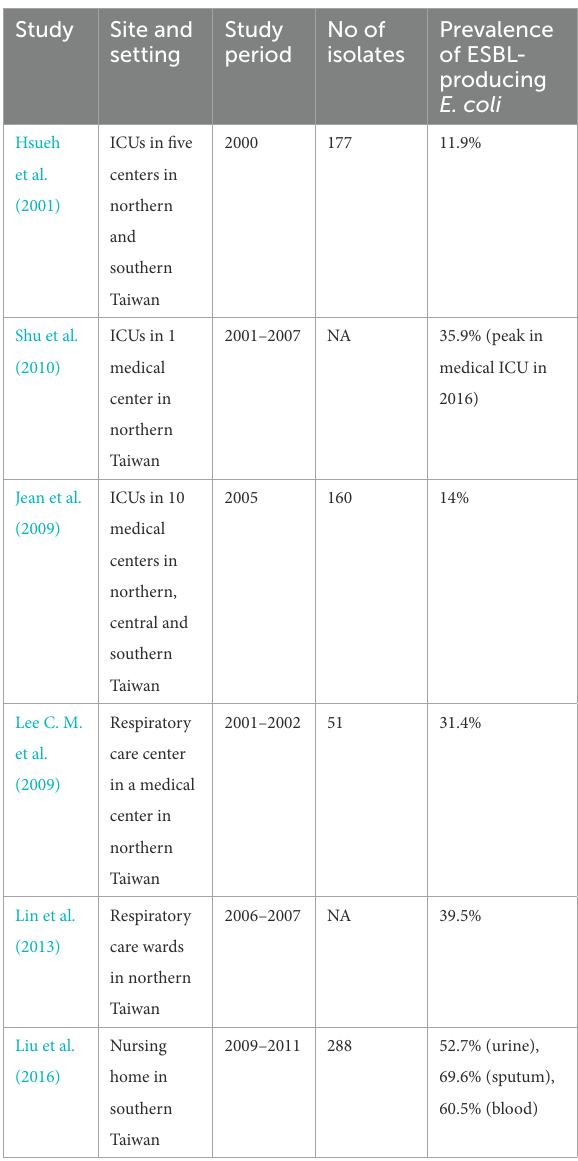
TABLE 3 Prevalence of extended-spectrum β -lactamases (ESBLs) among E. coli in specific